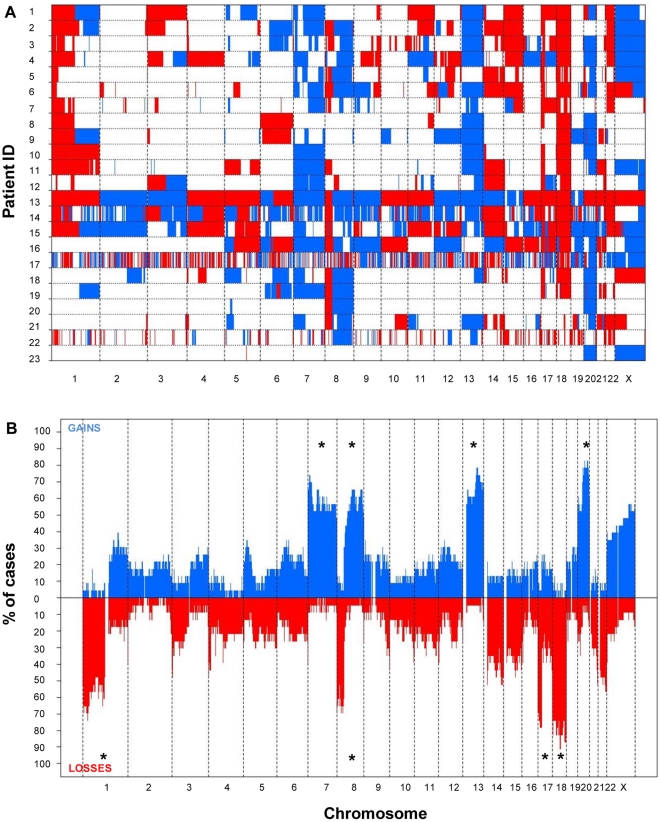
Metastatic colorectal cancer genome for the 23 CRC patients studied.In panel A an overall view of both the gained (blue areas) and lost (red areas) chromosome regions across the genome are shown for the 23 patients genotyped on the Affymetrix 500k SNP array platform. In panel B a summary plot showing the frequency of CN gains (plotted above zero values in the x-axis) and losses (plotted below zero values the x-axis) detected for each individual chromosome, is displayed. Those chromosome regions most frequently showing recurrent losses and gains by SNP arrays were localized in chromosomes 1p, 8p, 17p and 18, and involved the whole chromosome 7 and the 8q, 13q and 20q chromosome regions, respectively.